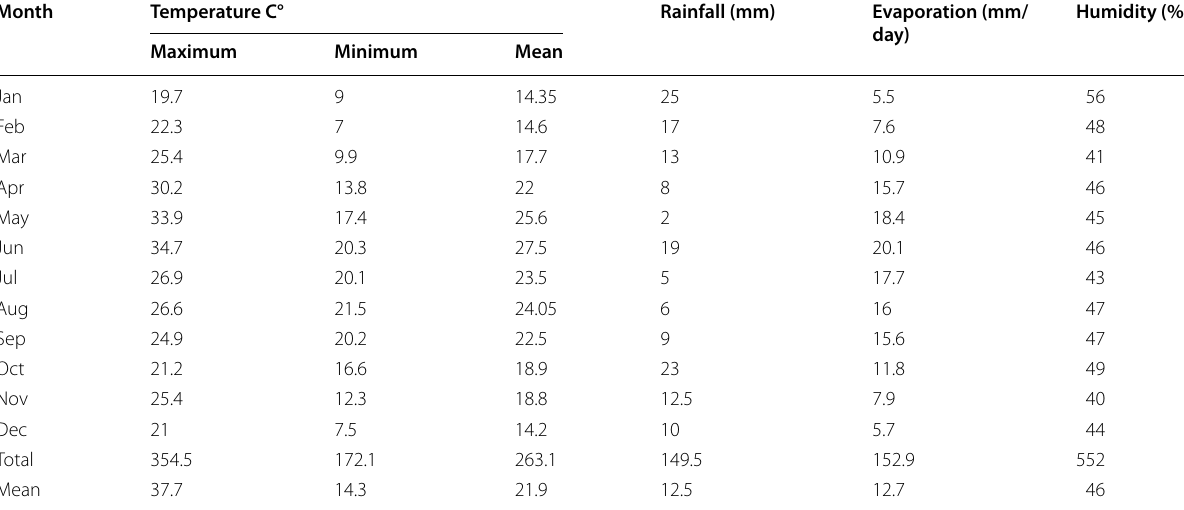
Table 1 The average climatic records of the study area during the period (EMA 2019)